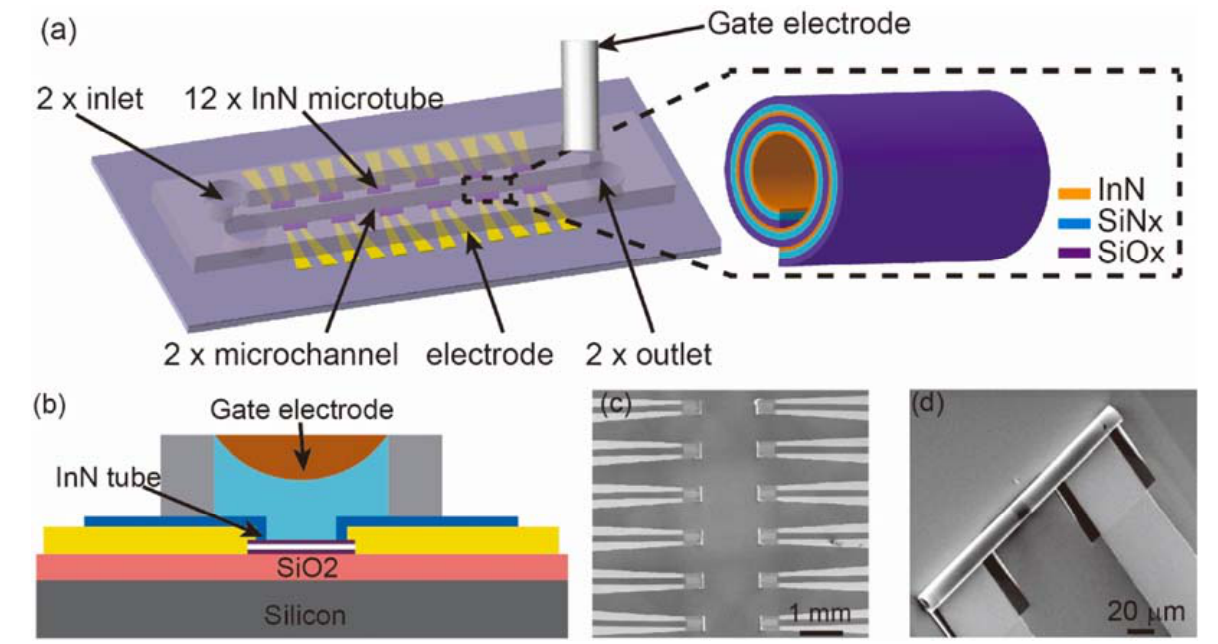
Figure 3. ( a ) FETs distributed along two microfluidic channels and ( b ) the FET architecture. ( c ) Scanning electron microscopy (SEM) of the sensor array. ( d ) Magnification of the SEM image with an emphasis on the structure of the InN microtube. Reprint by permission from Elsevier.